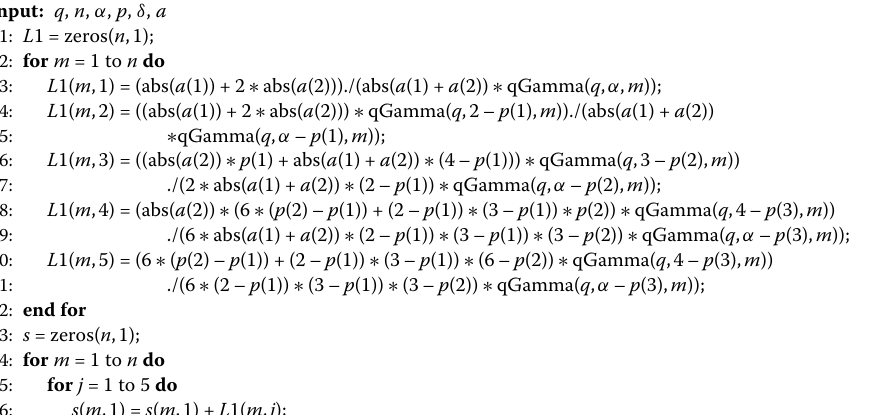
Algorithm 5 The proposed method for calculating Λ